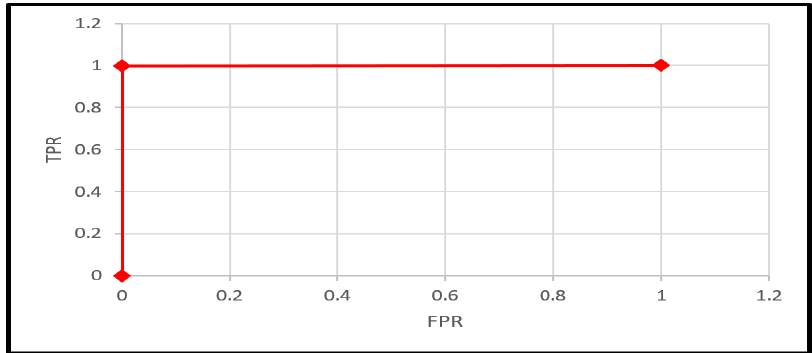
Figure 6. Comparison among the selected models of all criteria (data 2009–2013 and 2018–2022).